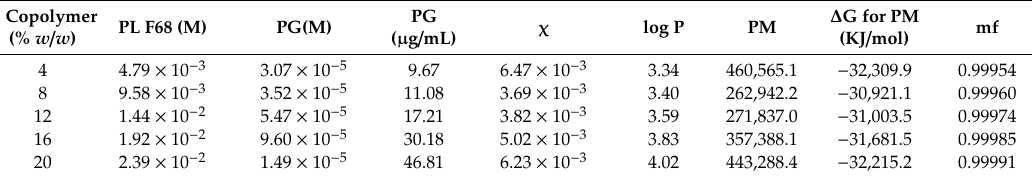
Table 3. PG solubilization capacity of Pluronic F68 dispersions in a PBS pH 7.4, calculated